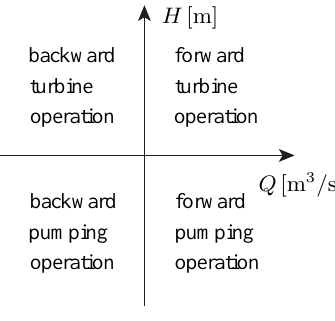
Fig. 1. Four quadrants of turbine